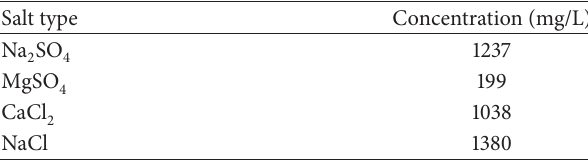
Table 2: Chemical composition of synthetic mine water [3].